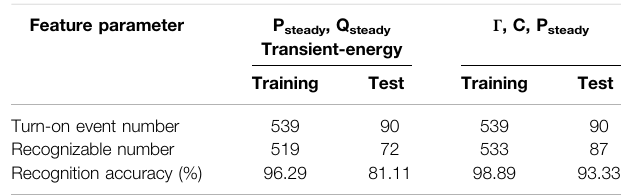
( Figure 8 ). Collecting Electric Information Unit (CEIU) and